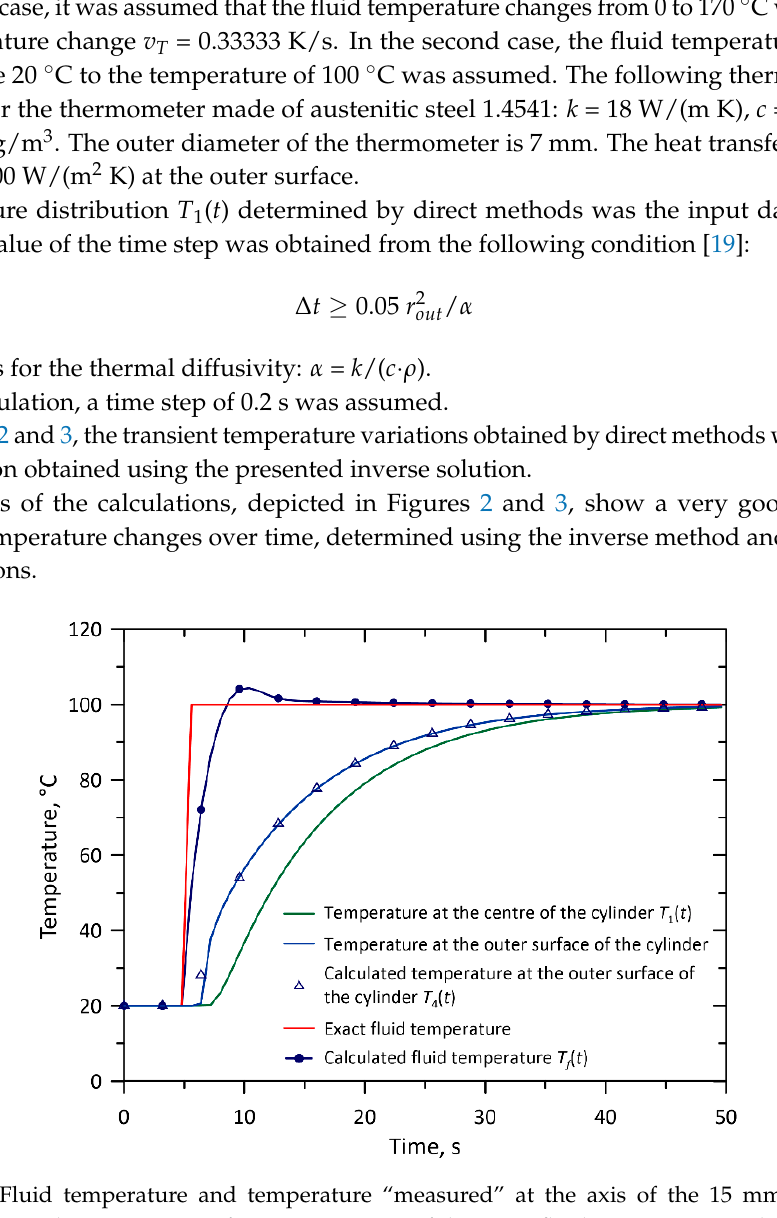
Figure 3. Fluid temperature and the temperature “measured” at the axis of the 15 mm diameter thermometer and on its outer surface—comparison of the exact temperature with the results obtained from the solution of the inverse problem for the linear rise in fluid temperature.